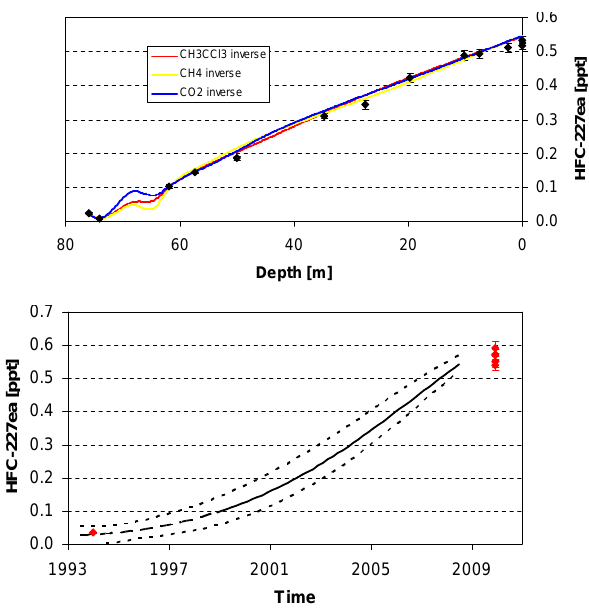
Fig. 1. Mixing ratios of HFC-227ea as a function of depth as mea- sured in air samples collected from deep firn in Greenland in 2008 (upper part) alongside with three modelled diffusivity profiles as de- scribed in Sect. 3.1. The lower part shows the northern hemispheric temporal trend inferred from these mixing ratios via inverse mod- elling. The short-dashed lines represent the maximum of the two σ root mean square deviations while the continuous line shows the mean of the three corresponding best estimate trends. The lack of data between 62 and 74m leads to high uncertainties in the trend be- fore 1999 which is why it is displayed as a long-dashed line. The ad- ditional red points are all from northern mid-latitude samples. They originate from upper tropospheric aircraft samples (2009), and an archived air sample collected at Niwot Ridge near Boulder, USA